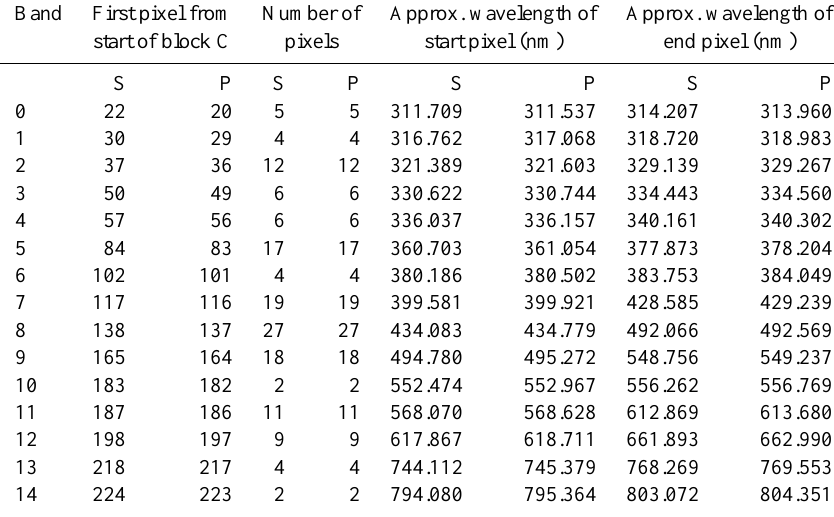
Table 5. GOME-2 Metop-A PMD band definitions (v3.1). This set is valid from 11 March 2008 during orbit 7227. Here “P” indicates PMD-P which measures intensity polarized parallel to the spectrometer’s slit, and “S” indicates PMD-S which measures intensity polarized perpendicular to the spectrometer’s